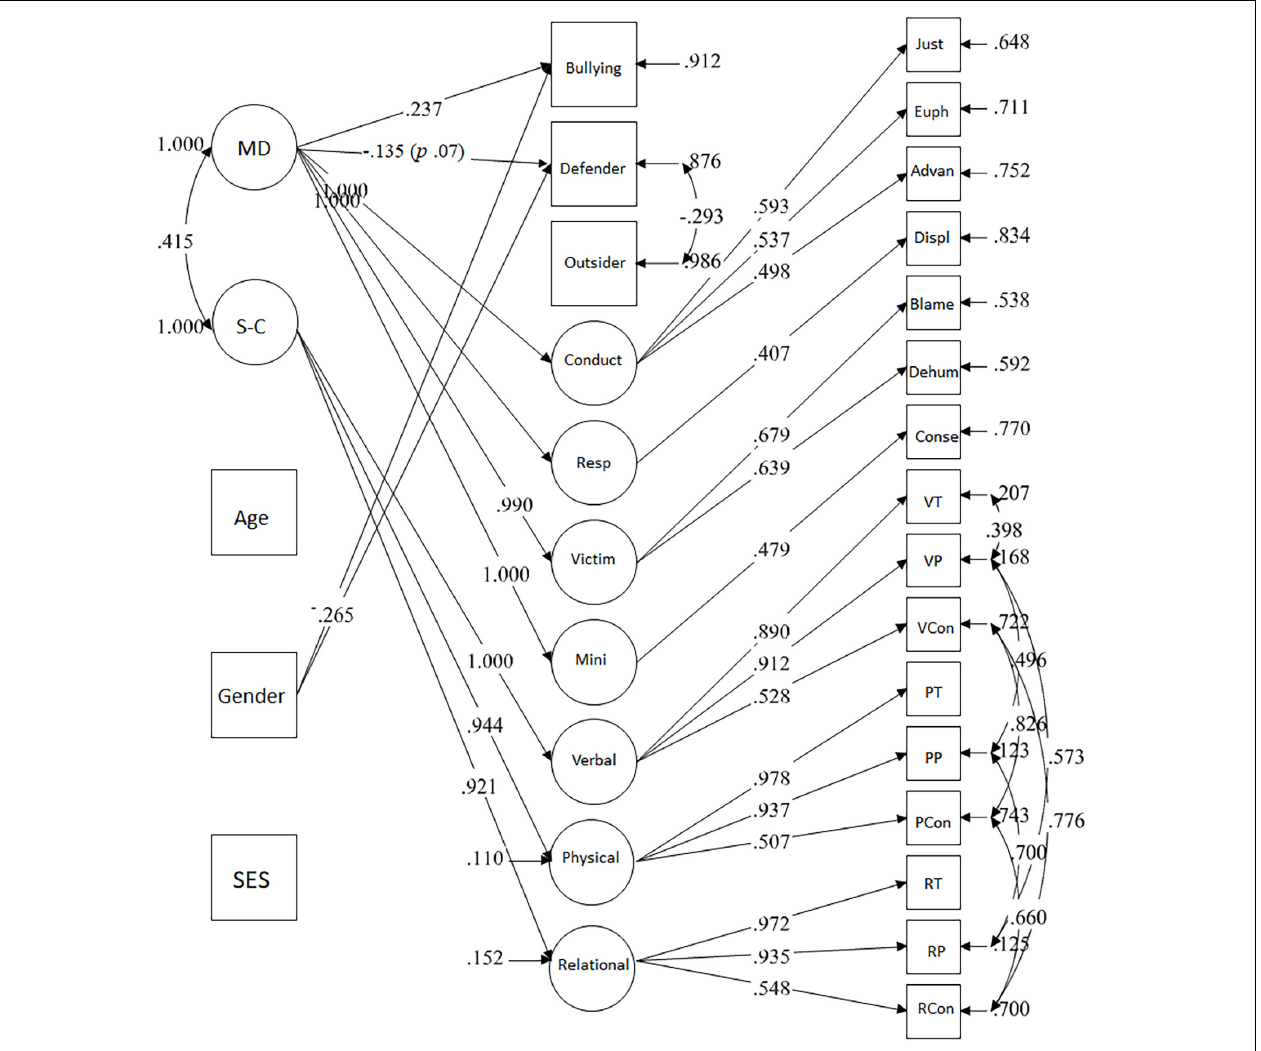
FIGURE 2 | Moral dimensions and forms of participation in bullying. Only significant paths ( p < 0.05) are displayed in the figure. Standardized indices. Md, Moral Disengagement, S-C, Socio-conventionality of the moral rules for aggression; Conduct, conduct restrictuding mechanisms, Resp, responsibility restructuring mechanisms, victim, victim restructuring mechanism, Mini, consequence minimization moral disengagement mechanism, mJust, moral justification mechanism, Euph, euphemistic labeling mechanism, Advan, advantagious comparison mechanism, Displ, responsibility displacement mechanism, Blame, victim blame mechanism, Dehum, dehumanization mechanism; VT, verbal violence teacher’s permission, VP, verbal violence principal’s permission, VCon, verbal violence context dependence; PT, physical violence teacher’s permission, PV, physical violence principal’s permission, PCon, physical violence context dependence; RT,